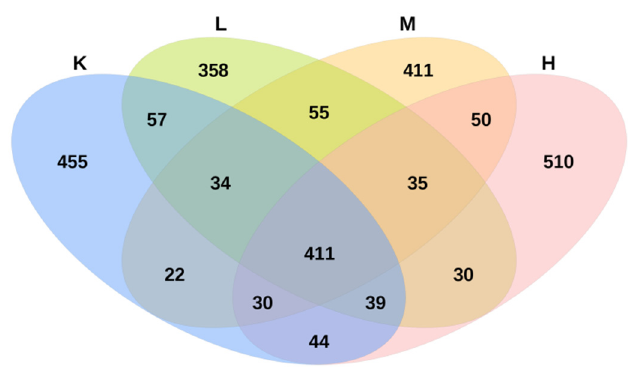
Figure 6. Species enrichment Venn diagram.